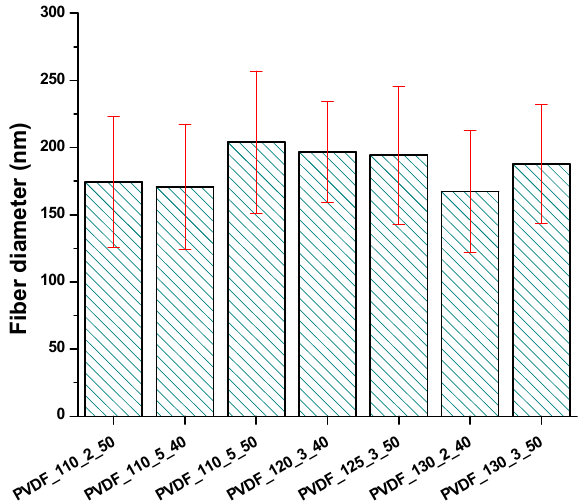
Figure 7. The fibre diameter of various nanofibrous membranes.